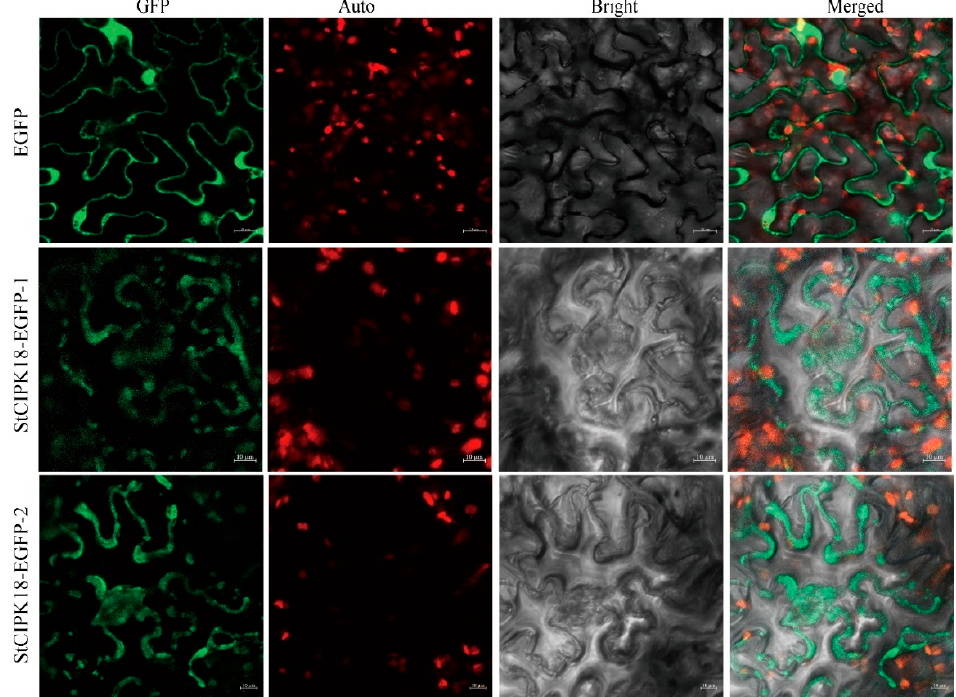
Figure 2. Subcellular localization of the StCIPK18 protein in tobacco leaf cells. The EGFP and StCIPK18-EGFP fusion protein transiently expressed in tobacco. GFP: EGFP fluorescence signal in the dark field; Auto: Autofluorescence of chlorophyll; Bright: Cell morphology under bright field; Merged: Combination field. The scale bale represents 10 μ m.